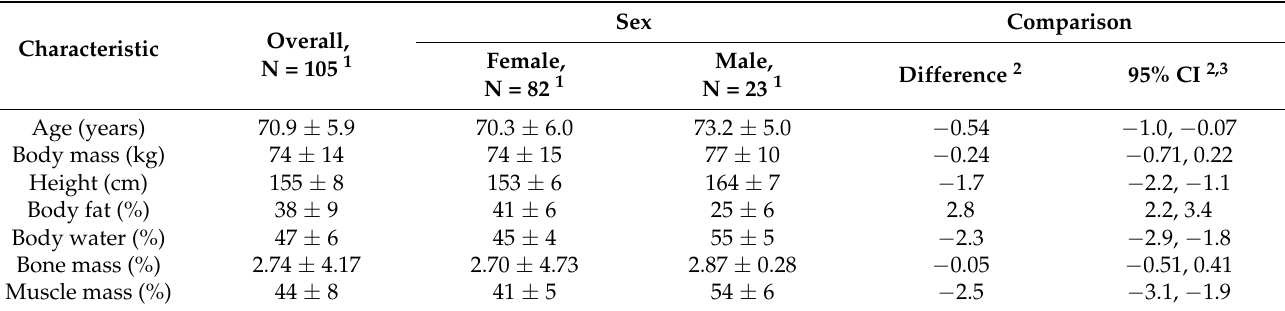
Table 1. Overall and aggregated by sex descriptive statistics of body composition parameters from the study